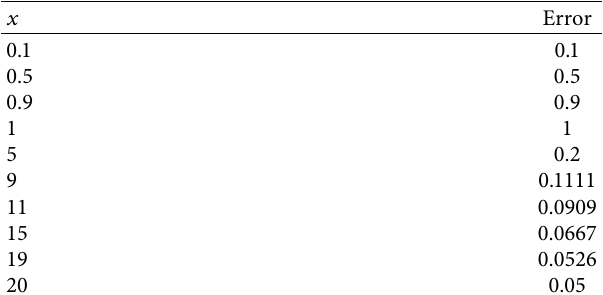
� 1. with β 1 2 � 1. with β 2 1